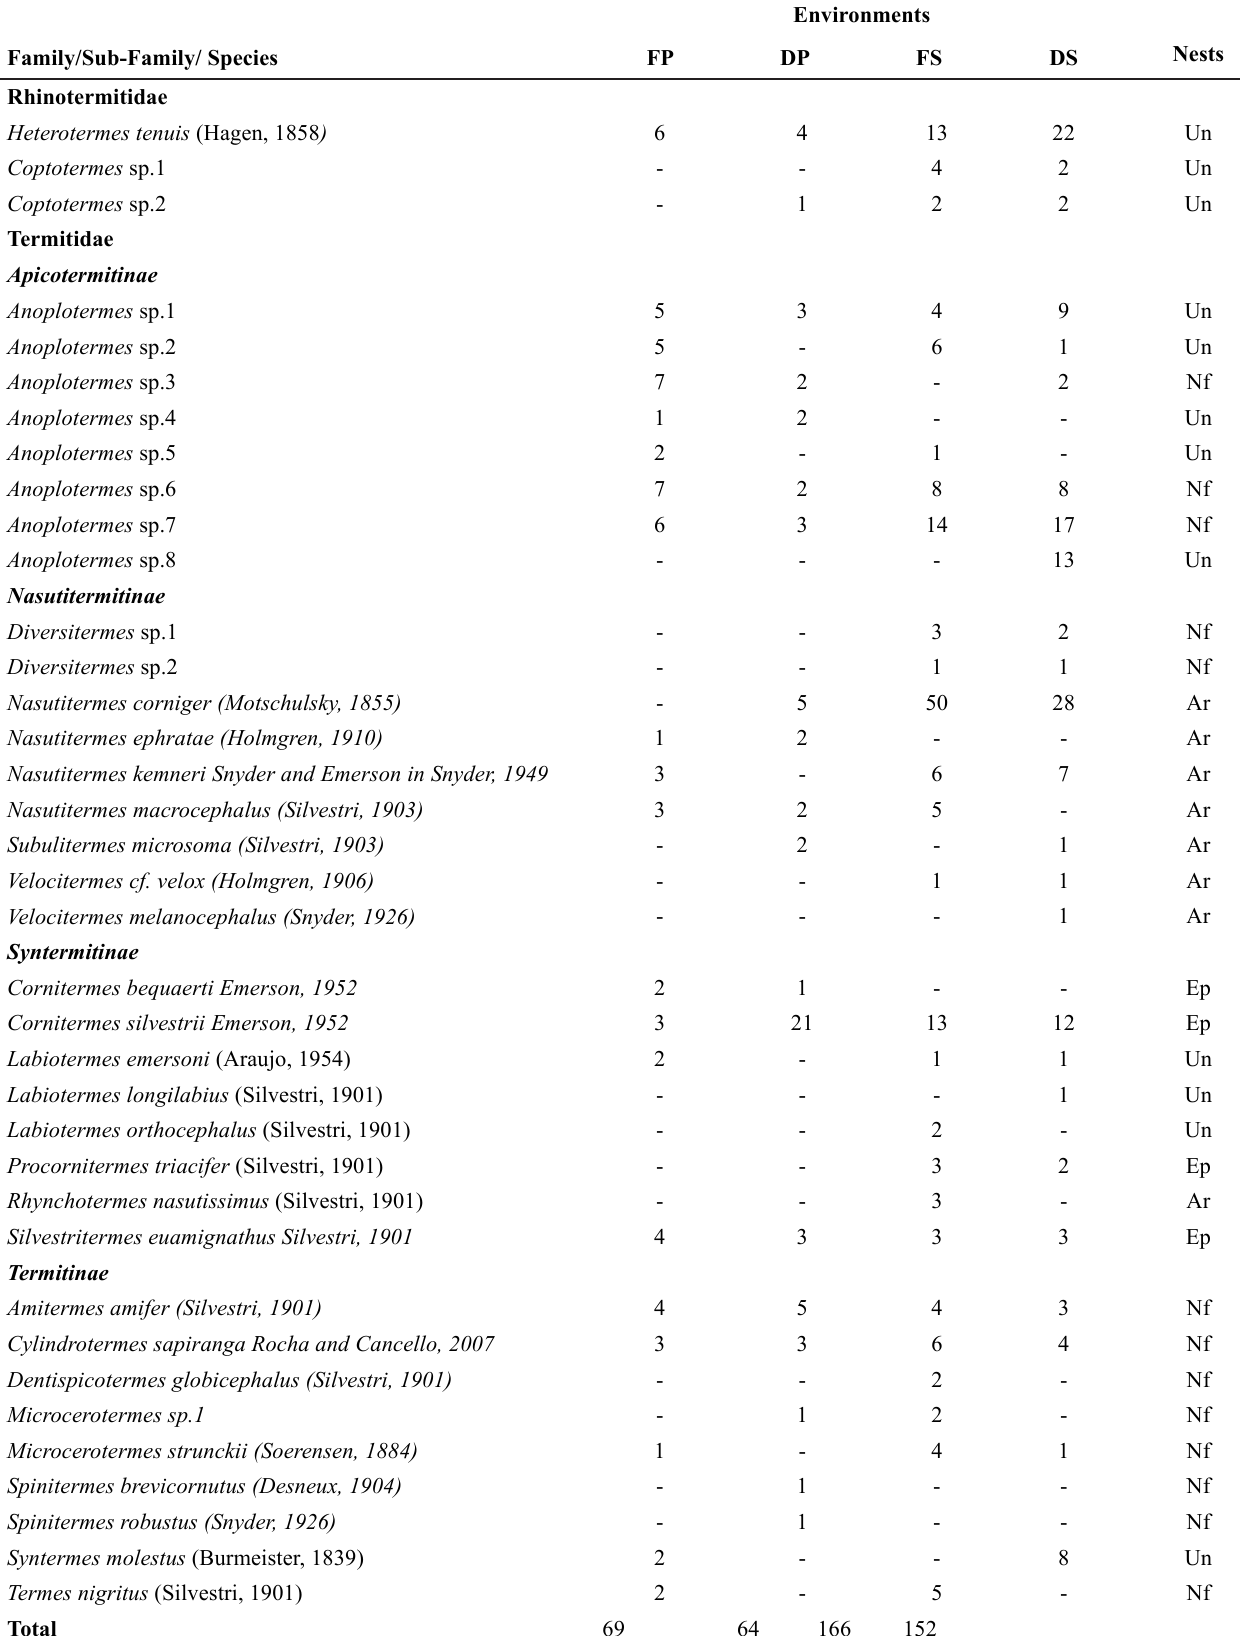
Table 1 . Abundance of termite species (Insecta: Isoptera) collected in environments of flooded pasture (FP), dry pasture (DP), flooded savanna (FS) and dry savanna (DS) and the place of their nests (Un – Underground, Ar – Arboreal, Ep – Epigeal, Nf – Not Found) in the Pantanal, in the town of Cáceres,